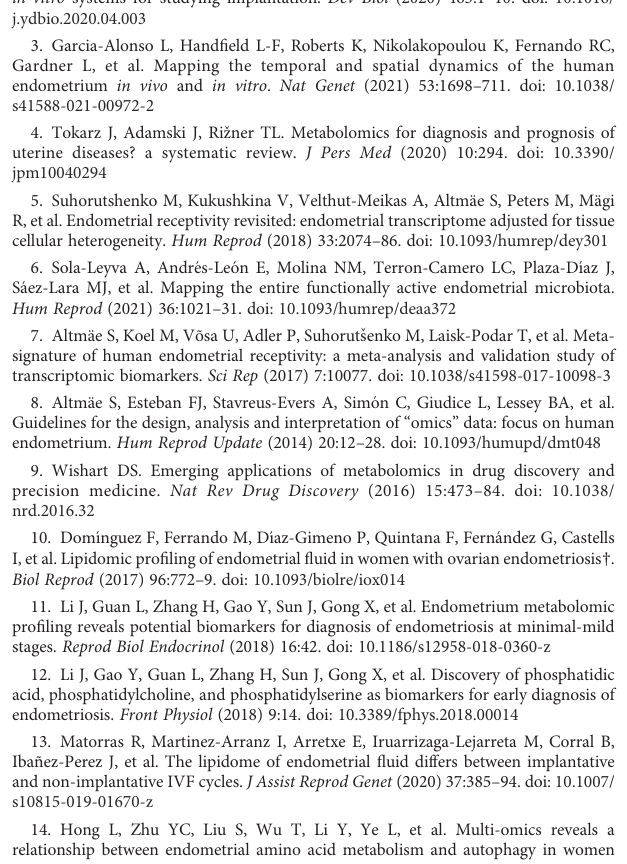
SUPPLEMENTARY TABLE 2 Quantitative score (14-item) of adherence to the Mediterranean Diet. The participants were asked to choose the best option for each question. ‘ < ’